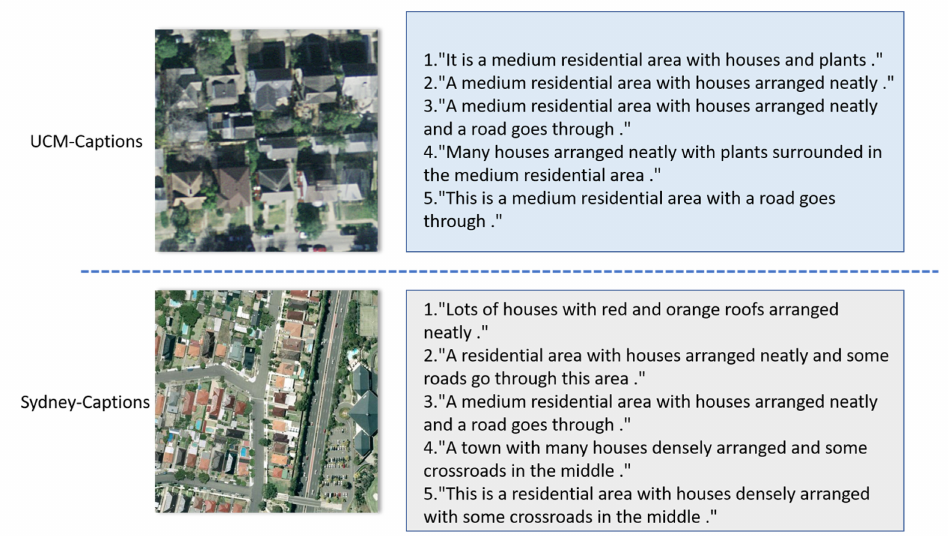
Figure 8. Schematic diagram of remote sensing samples and corresponding five captions